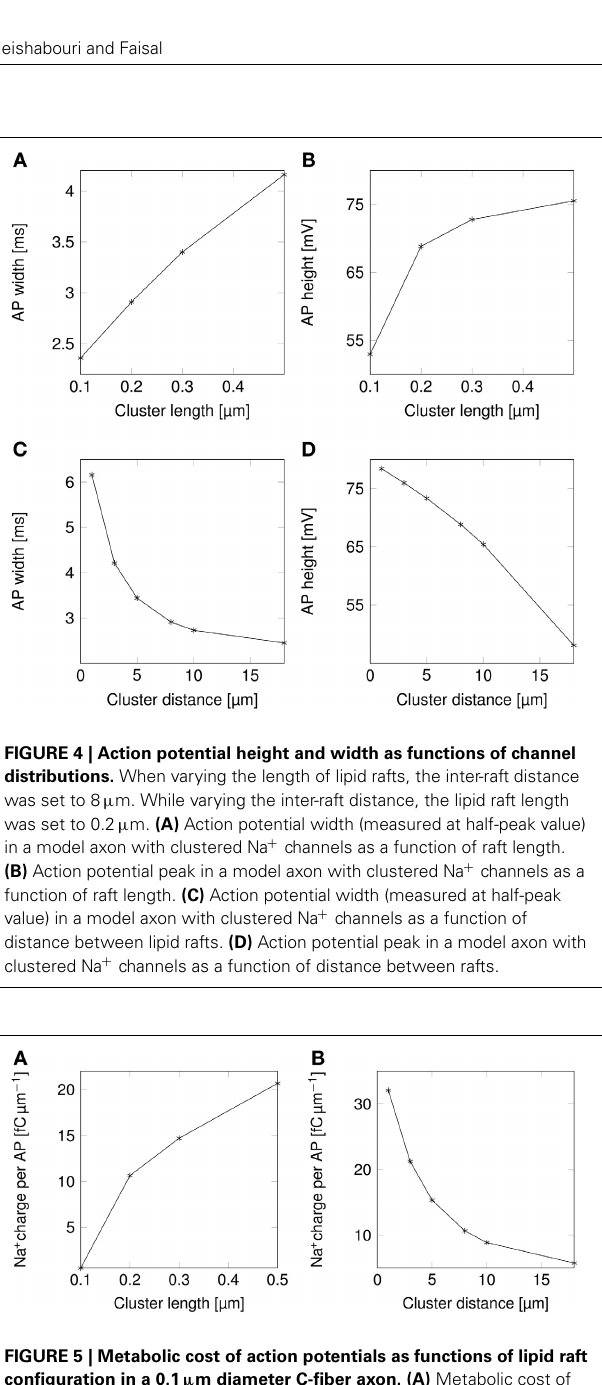
current due to the discrete nature of ion channel conductance has an impact on the metabolic cost of APs. Stochastic simulations yield a median value of 16 fC µ m − 1 per AP in axon with clustered or uniformly distributed channels.